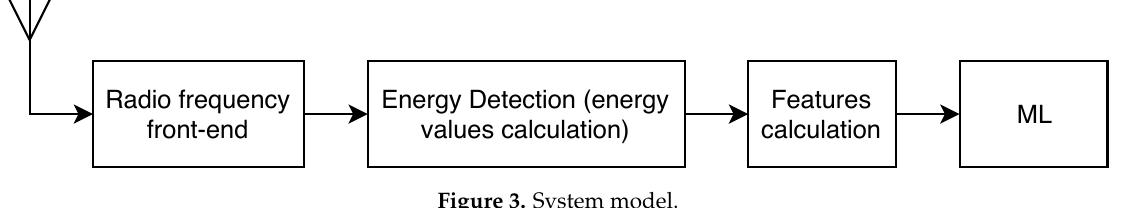
Figure 3. System